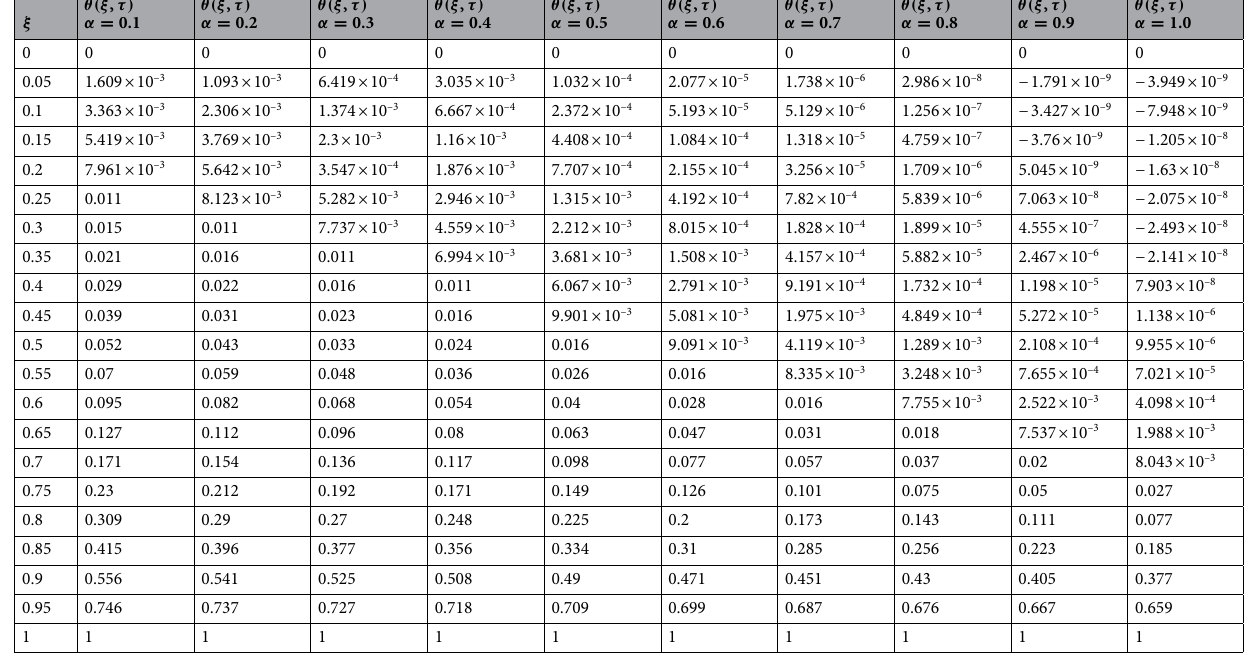
Table 2. The effects of different values of fractional parameters on the temperature distribution.